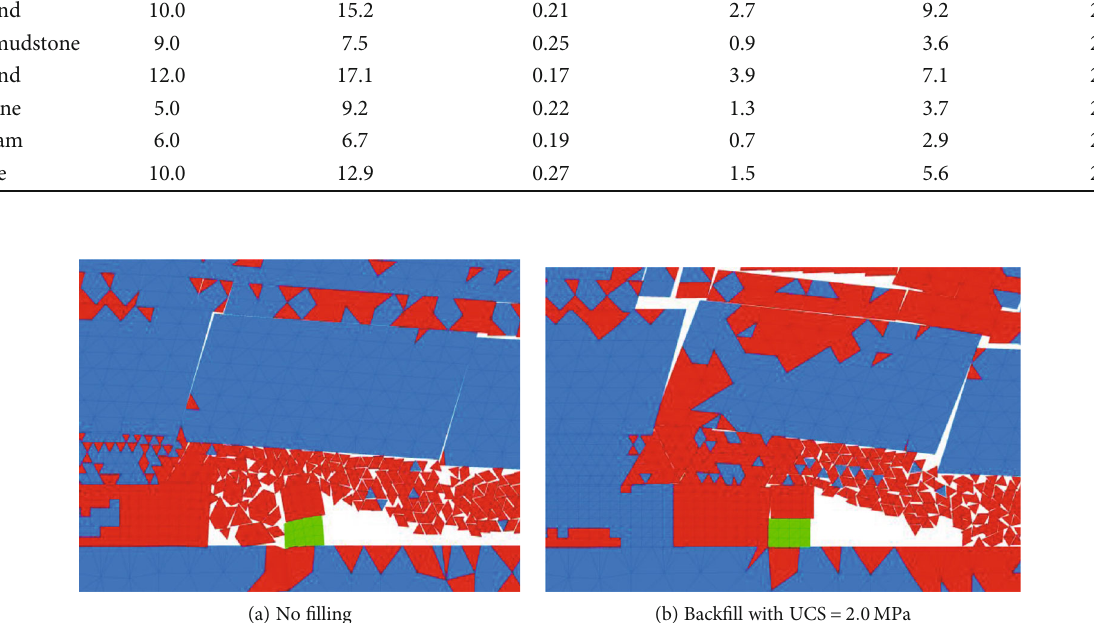
Figure 12: Plastic zone of the surrounding rock.